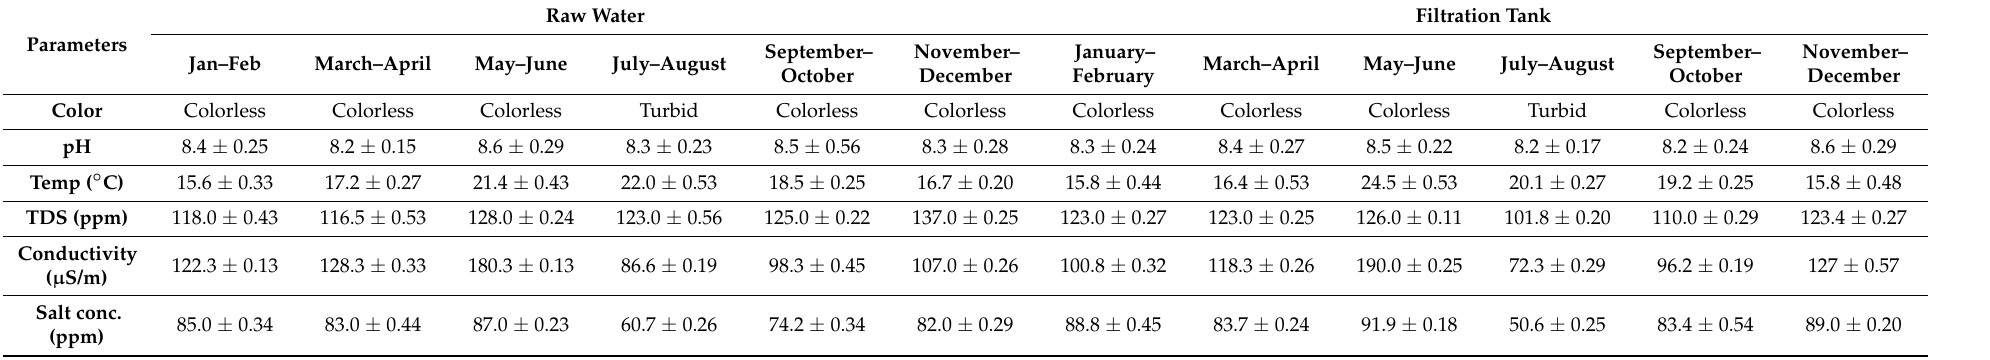
Table 2. Analysis of samples collected from source Ashwani